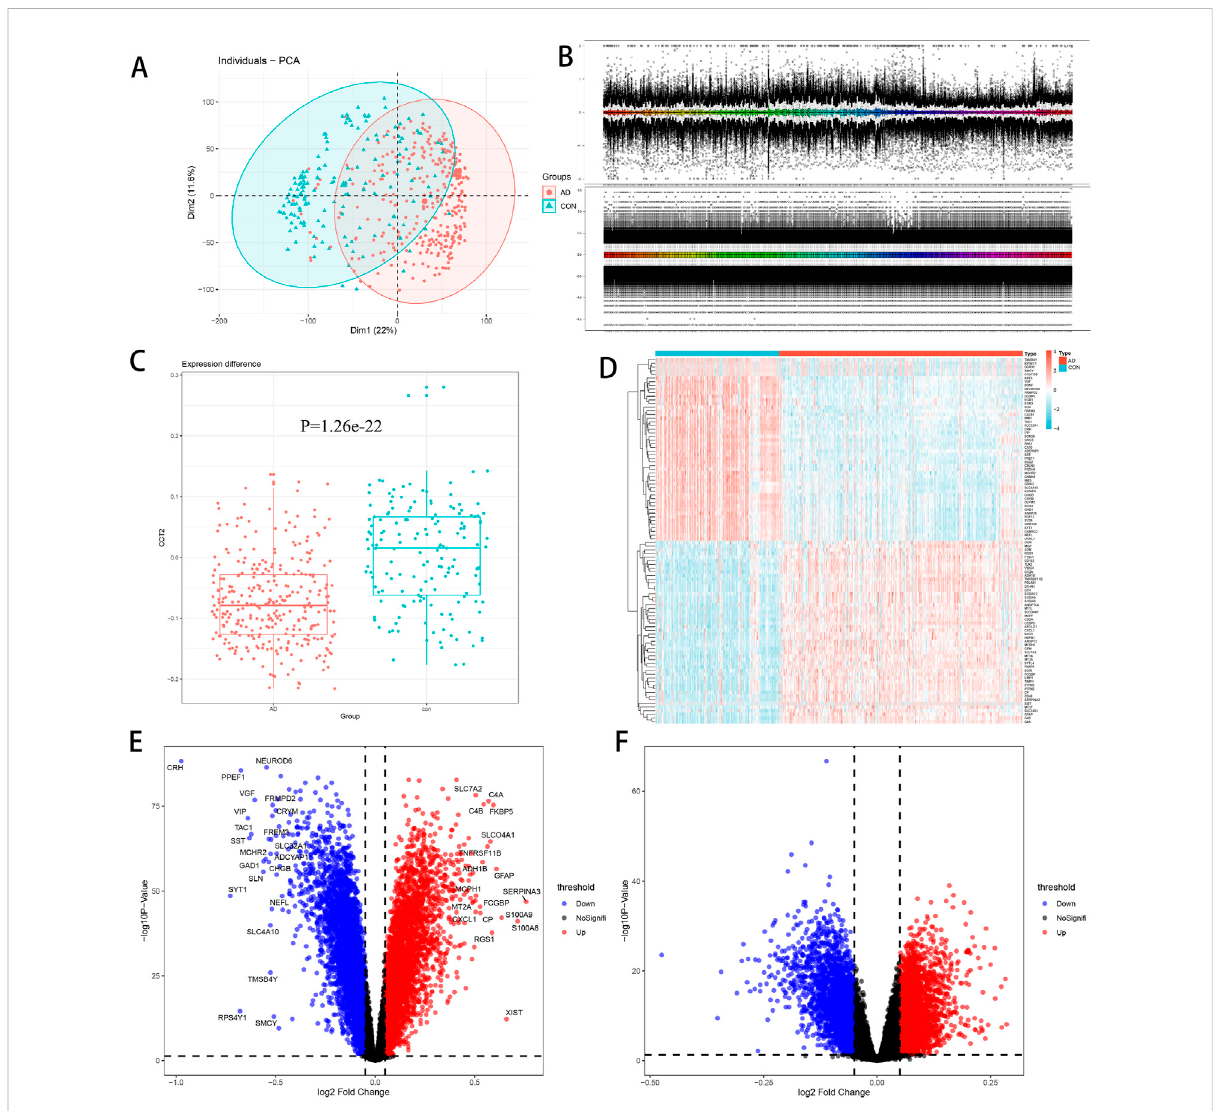
FIGURE 1 Differential expressionanalysis. (A) Principalcomponentanalysis (PCA) plotdemonstratingdifferencesamonggroups,with Alzheimer ’ sdisease (AD) in red and con in green. (B) Boxchart before and after standardization — the upper fi gure is before standardization; the following fi gure is after standardization. (C) Chaperonin containing TCP1 subunit 2 (CCT2) was downregulated in AD ( p = 1.26e-22, logFC = -0.07632). (D) Heatmap of the top 50 upregulated and downregulated genes between AD and control. (E) Volcano plot of AD-con, with upregulated genes in red and downregulated genes in blue. (F) Volcano plot of CCT2-low/high, with upregulated genes in red and downregulated genes in